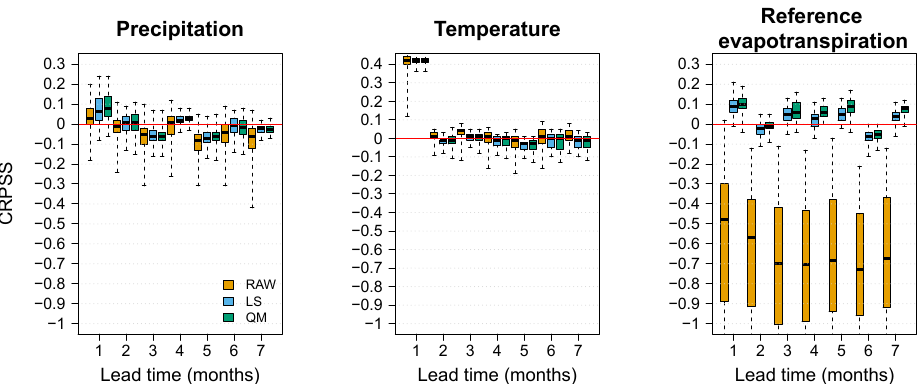
Figure 10. Spatial variability of skill in terms of accuracy for P , T and E T0 for the raw and post-processed forecasts of February as a target month at different lead times. Box plots represent the values of CRPSS, see Eq. (8) with climatology as reference, of all the 662 or 724 grid points covering